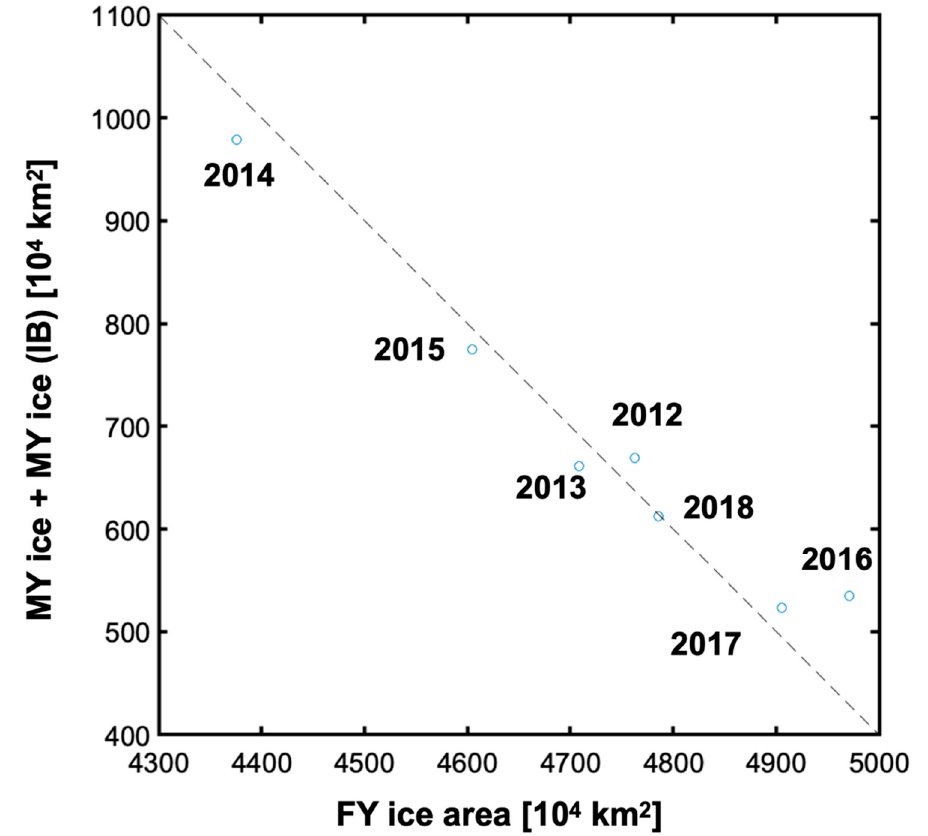
Figure 11. Scatter plot for the FY ice and MY and MY (IB) ice around Lützow-Holm Bay (67–71° S, 32–44° E).